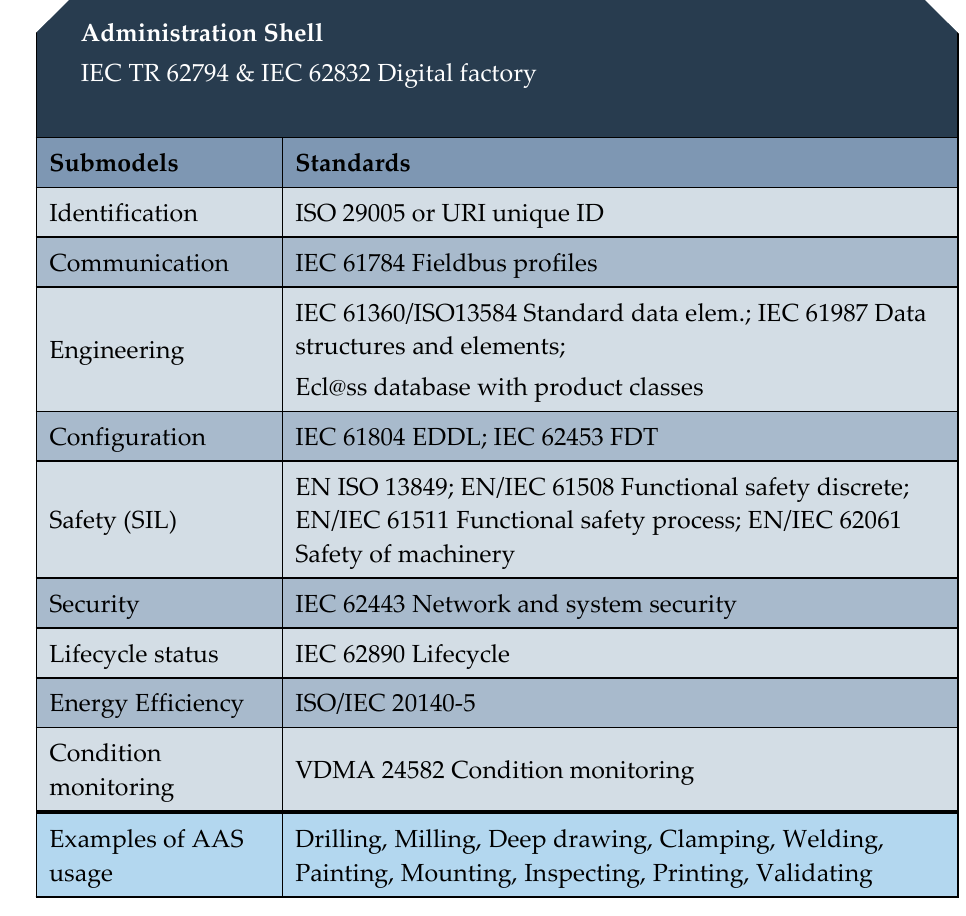
Figure 4. Possible AAS sub-models (inspired by [19]).